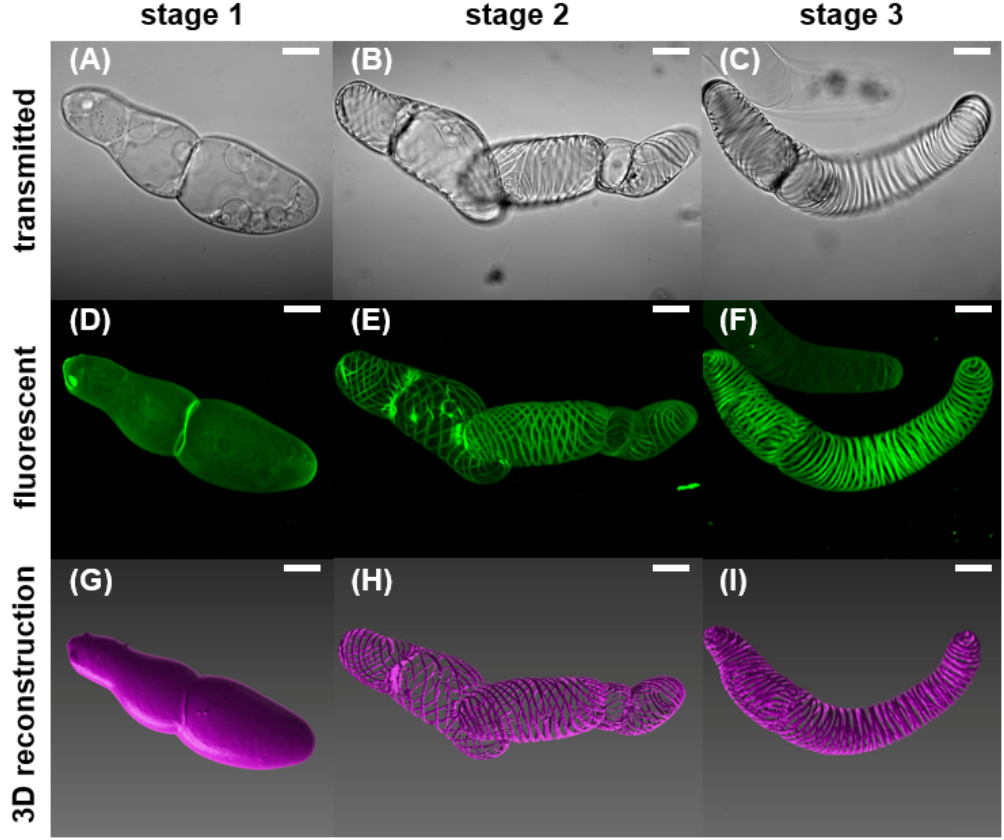
Figure 1. Transmitted, fluorescent, and 3D reconstructions of confocal images of the elongated VND7-inducible cells in the 3 stages of transdifferentiation. ( A , D , G ) Living cells which have only developed a PCW are identified as stage 1. The PCW is under stress from the internal turgor pressure. ( B , E , H ) Cells in stage 2 have both a PCW and the beginnings of a SCW. In this stage, the PCW has possibly begun hydrolyzing, and thin spiral bundles of SCW can be distinguished. The spiral patterning is characteristic of protoxylem vessels. ( C , F , I ) In stage 3, SCW thickening is observed; PCD has progressed; the tonoplast has ruptured and cytoplasmic contents have been removed from the cell. All scale bars are 20 µ